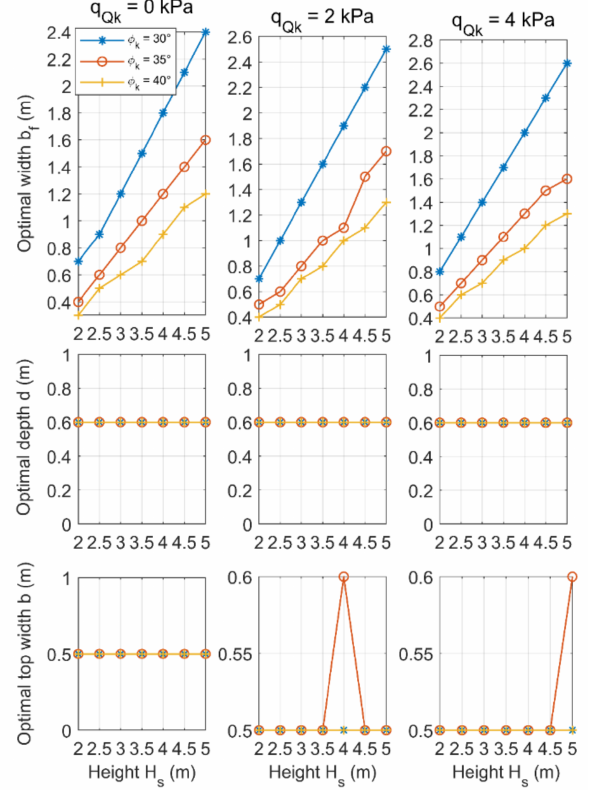
Figure 9. Optimal design for k = 1, β = 0 ◦ and γ = 18 kN/m 3